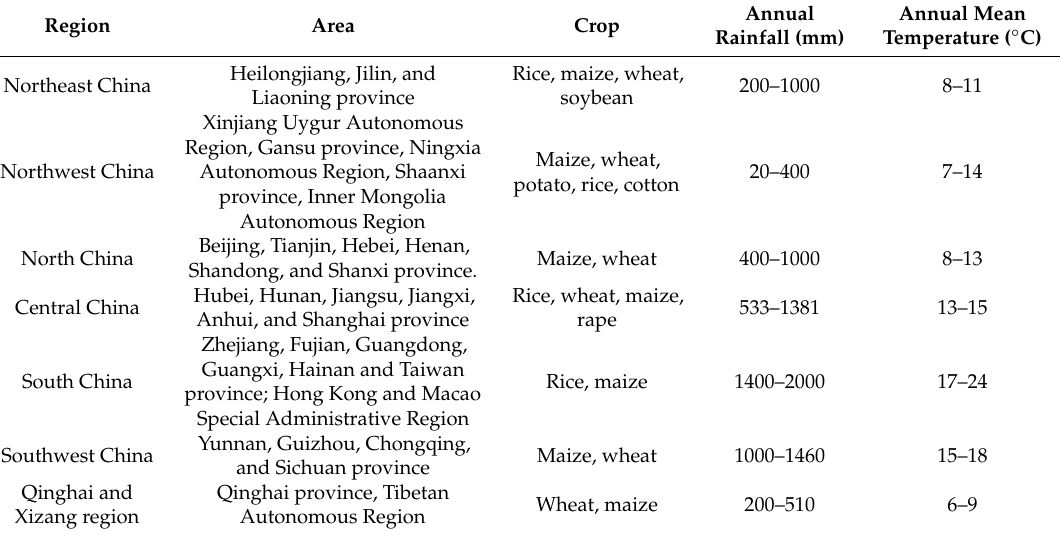
Table 1. Distribution of the geographic locations of the study